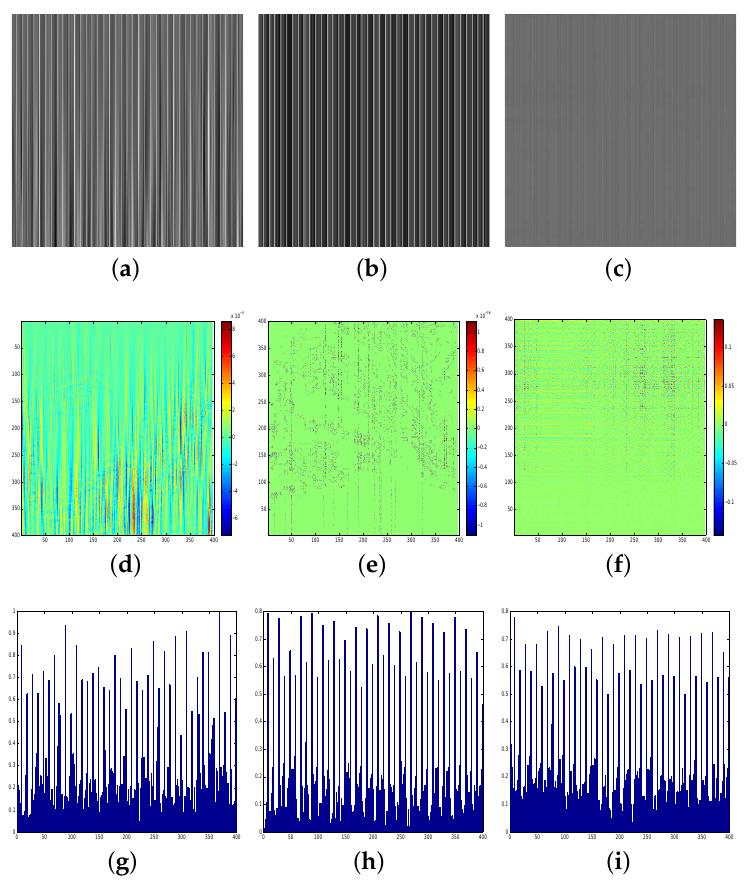
Figure 2. Stripe component of destriping results in Terra MODIS band 33 by ( a ) WAFT; ( b ) SLD; ( c ) LRSID; ( d ) The vertical gradient of ( a ); ( e ) the vertical gradient of ( b ); ( f ) the vertical gradient of ( c ). ( g ) The (cid:96) 2 -norm values for each column of ( a ); ( h ) the (cid:96) 2 -norm values for each column of ( b ); ( i ) the (cid:96) 2 -norm values for each column of ( c